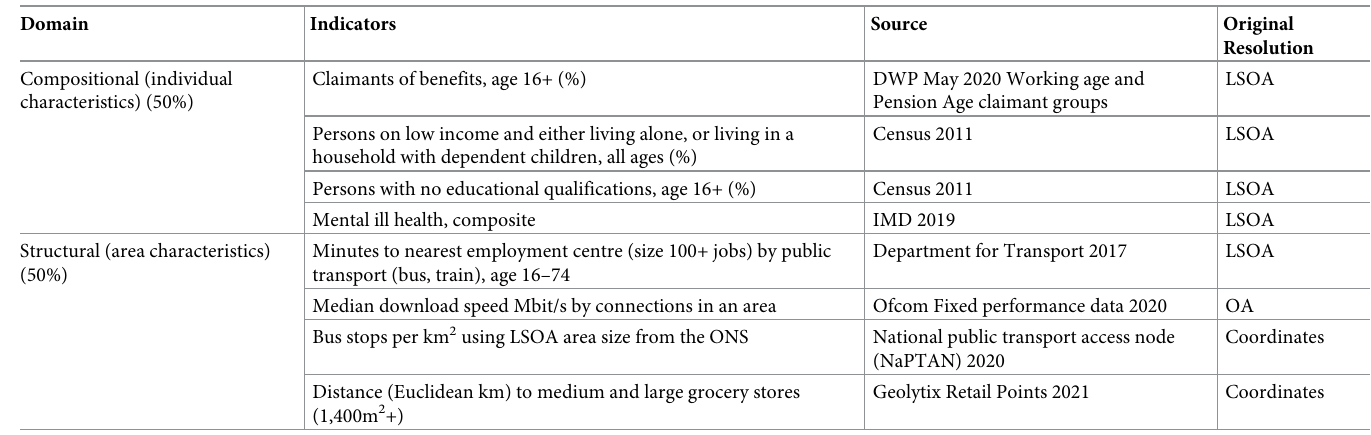
Table 2. Complex index domains and